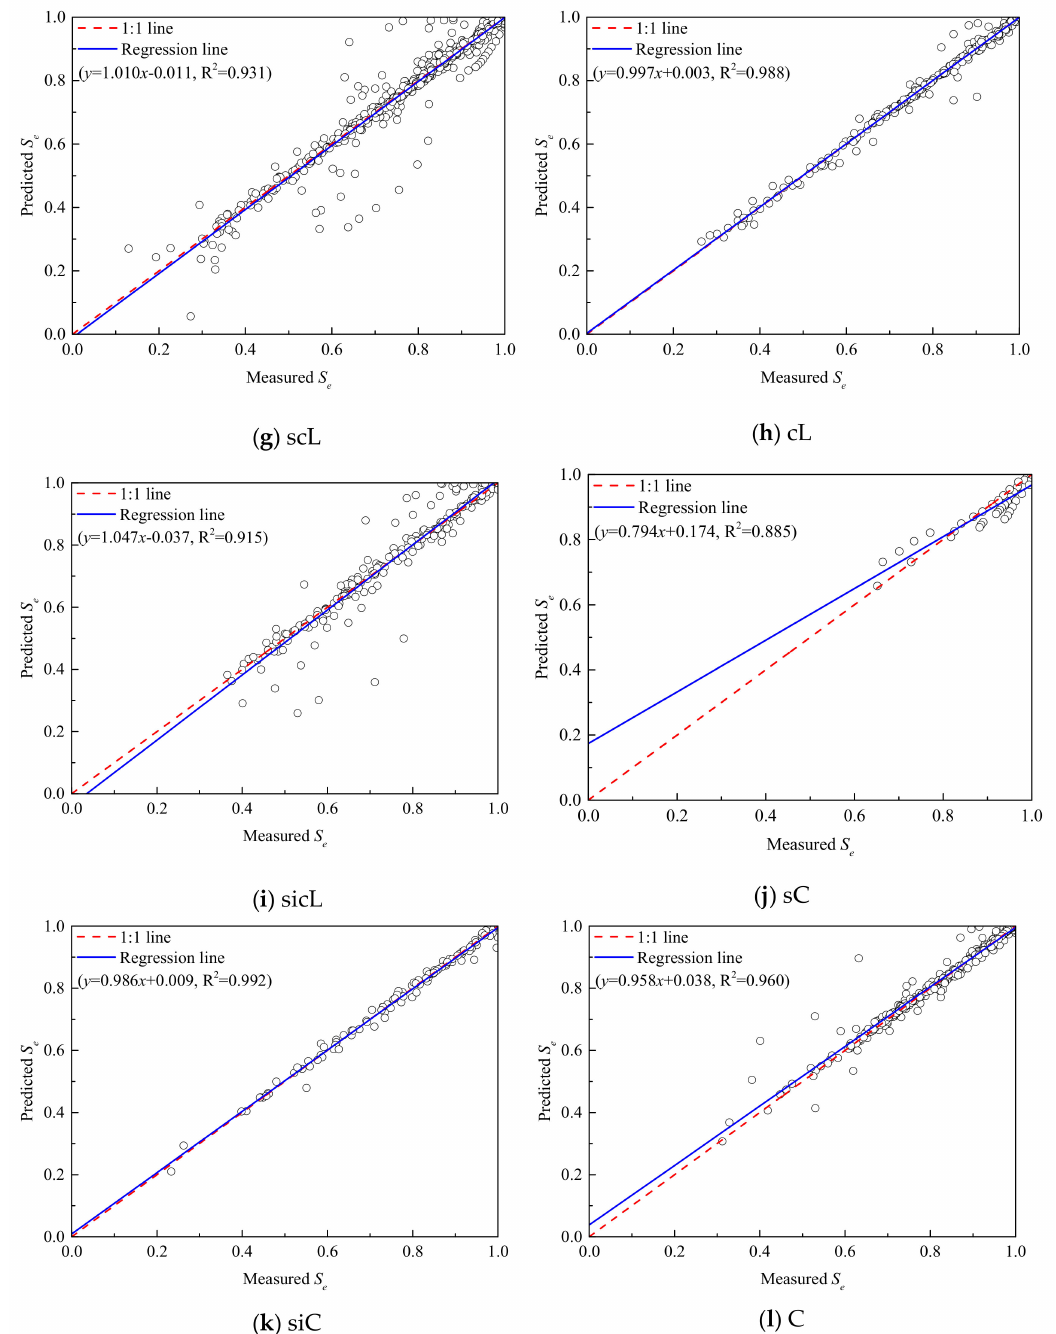
Figure 5. Comparison of the predicted SWCC obtained from the proposed approach and its corresponding measured values in